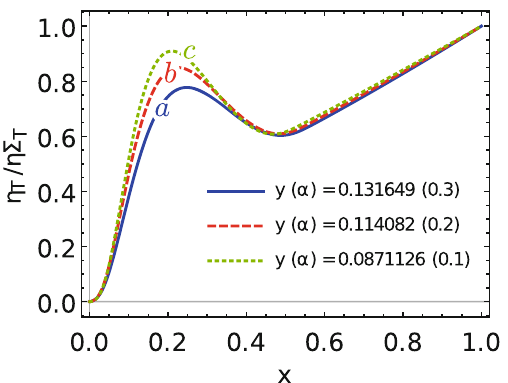
Fig. 5 Normalized Tolman–Whittaker Mass η T /η Σ for α = 0 . 1, n = 3 and different values of y . Values of y are read off Fig. 4